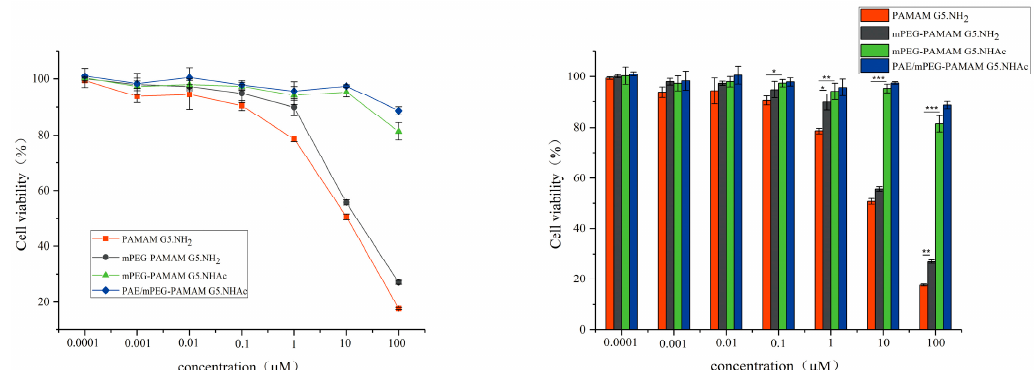
Figure 8. Cell viabilitiy of HepG2 cells following treatment with PAMAM G5.NH 2 (0.0001–100 µ M), mPEG-PAMAM G5.NH 2 (0.0001–100 μ M), mPEG-PAMAM G5.NHAc (0.0001–100 μ M),